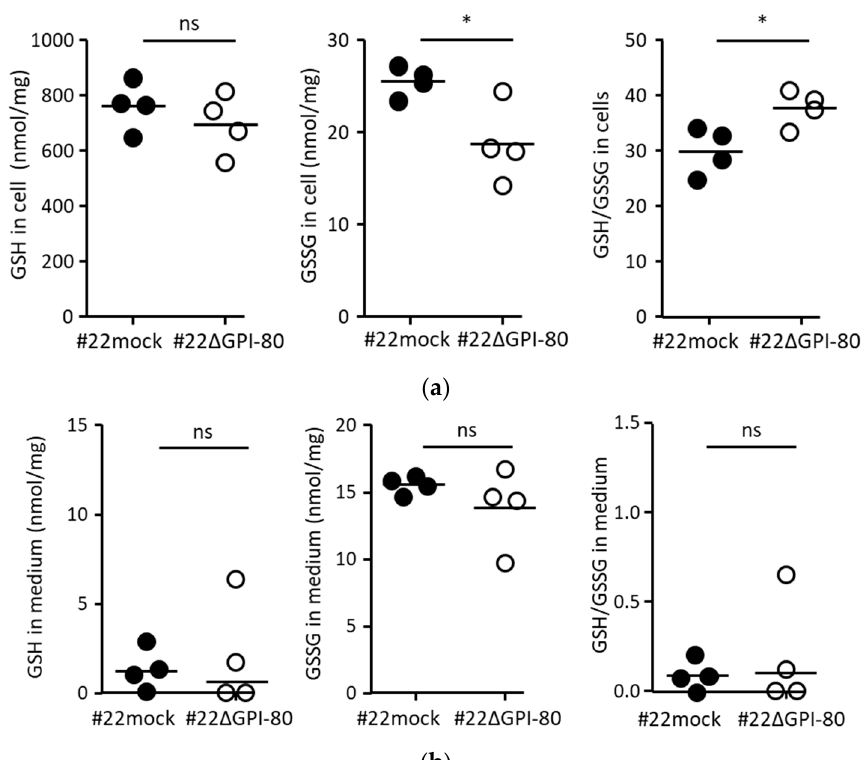
Figure 2. The ratio of GSH/GSSG was augmented in GPI-80-expressing cells. ( a ) The measurement of intracellular GSH/GSSG. The cells were cultured for 3 days, and approximately, 1 × 10 7 cells were collected using a cell scraper. The intracellular GSH (left panel) and GSSG (middle panel) levels were measured using the cell lysate from #22mock (closed circle) and #22 Δ GPI-80 (open circle) cells. The GSH and GSSG values (nmol/mg) were used for calculating the ratio of levels of GSH/GSSG (right panel). ( b ) The measurement of levels of GSH/GSSG in the conditioned medium. The cells were cultured for 3 days, and the media were collected. The levels of GSH (left panel) and GSSG (middle panel) were measured using the conditioned medium from #22mock (closed circle) and #22 Δ GPI-80 (open circle) cells. The GSH and GSSG values (nmol/mg) were used for calculating the ratio of levels of GSH/GSSG (right panel). The data are representative of four independent experiments, and the statistical significance was calculated using two-tailed unpaired Student’s t -test (*, p < 0.05; ns, not significant).